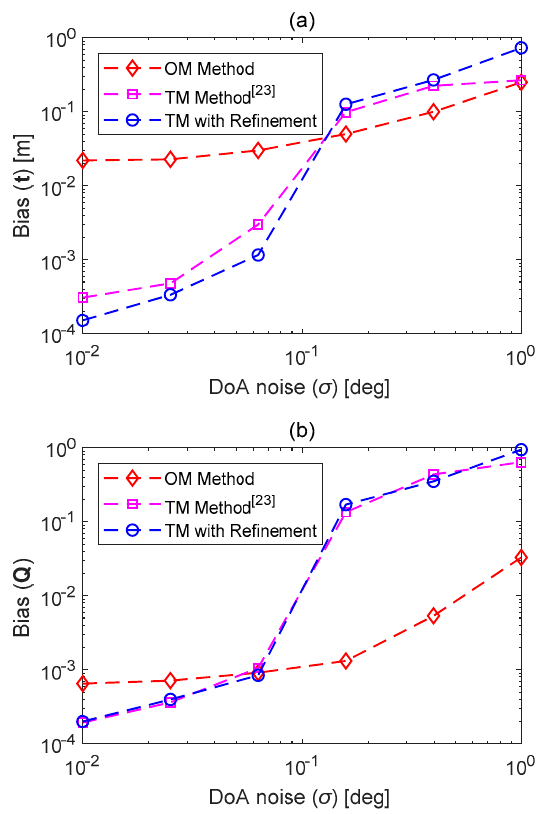
Figure 7. Bias for ( a ) translation vector estimate and ( b ) rotation matrix estimate when D = 1.5 m.